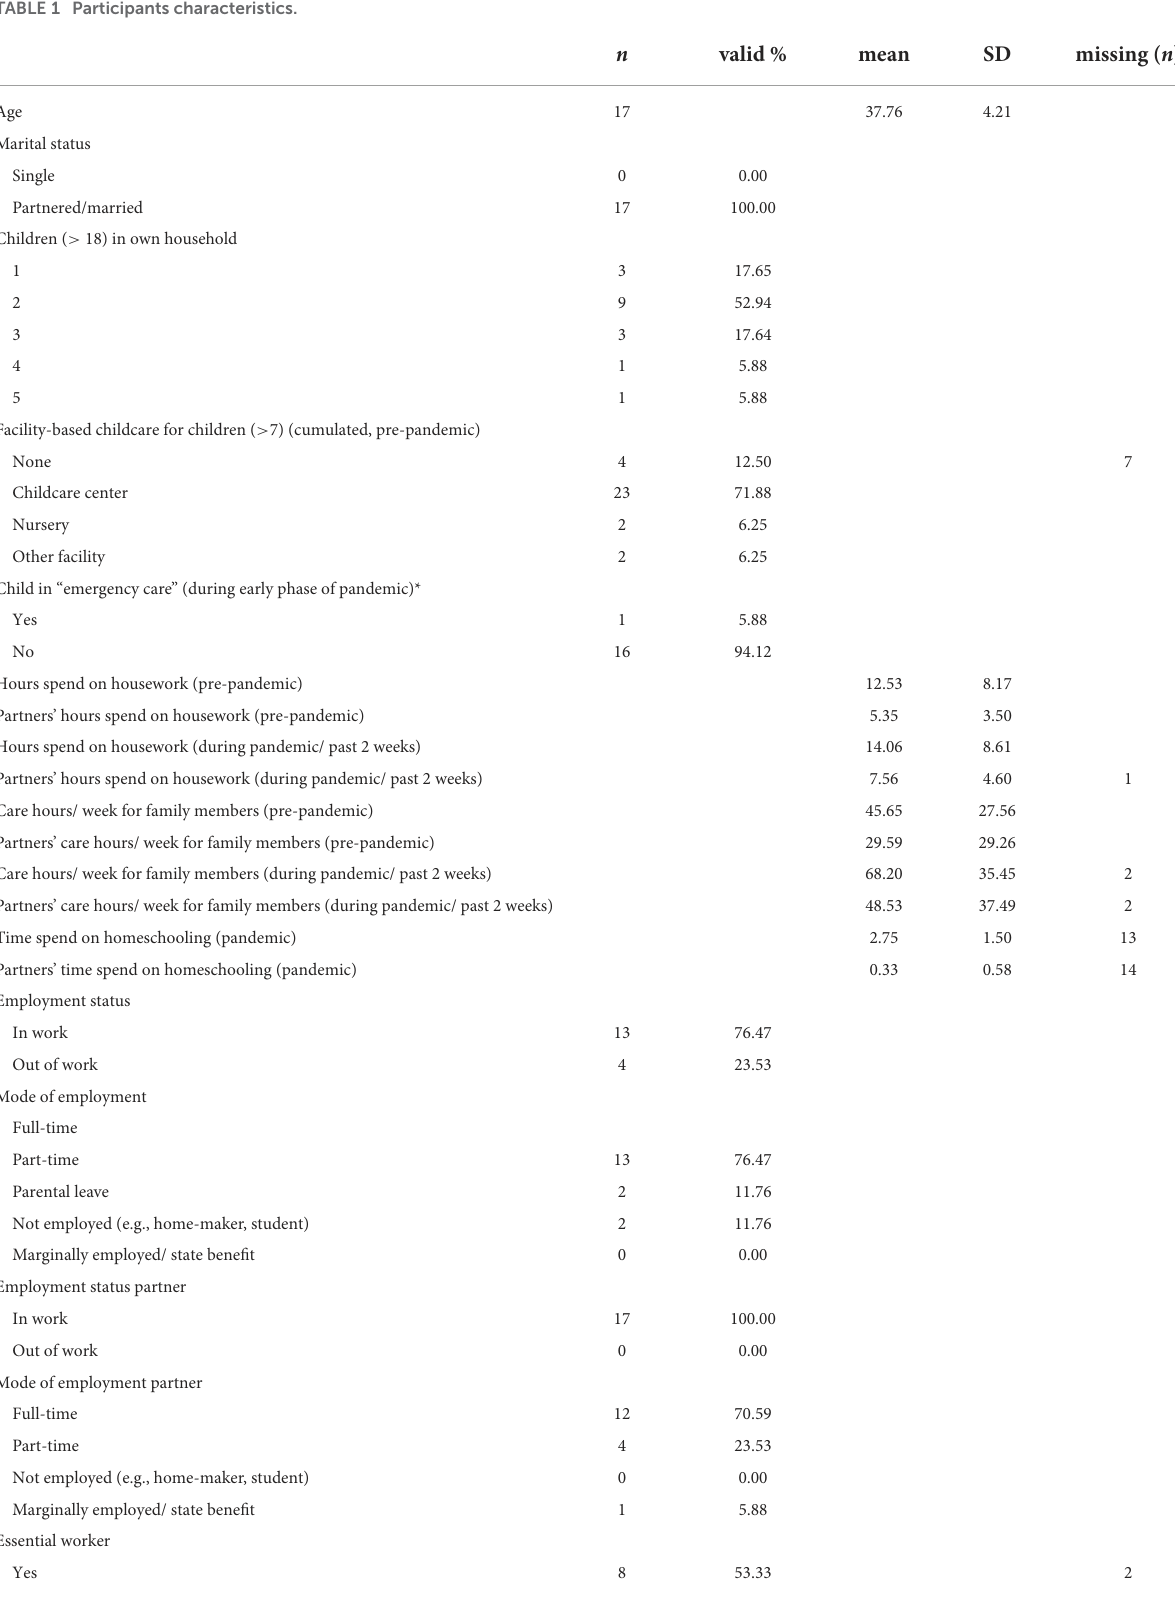
TABLE 1 Participants